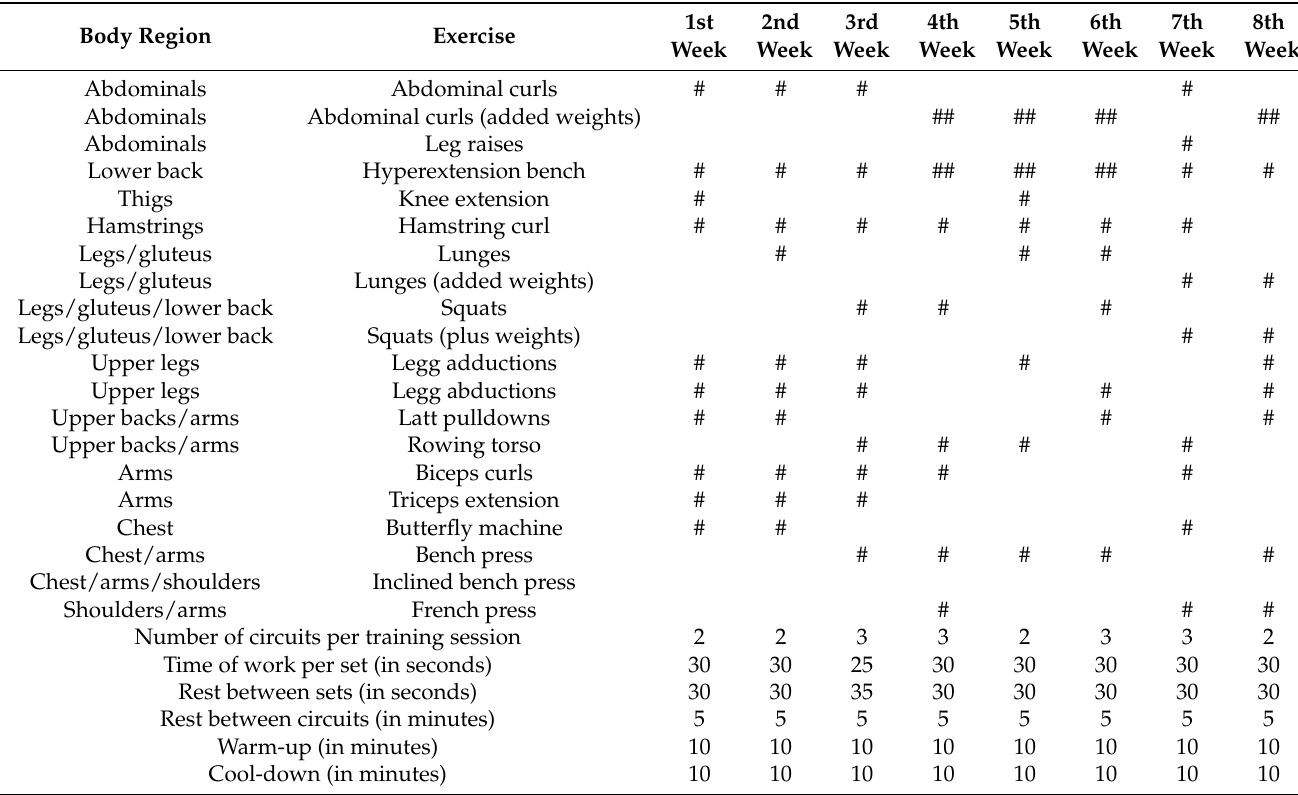
Table 1. Plan and program of the